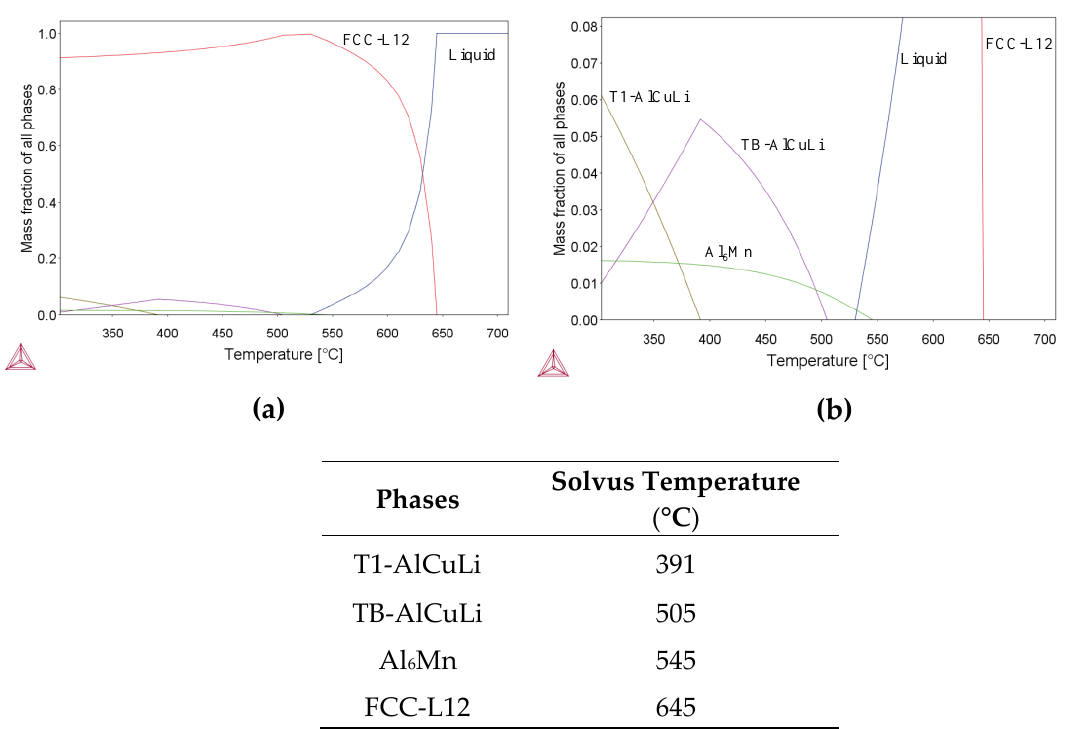
Figure 6. Phase diagram for Al – 4Cu – 0.85Mg – 0.3Mn-0.1Zn-0.75Li (wt. %).